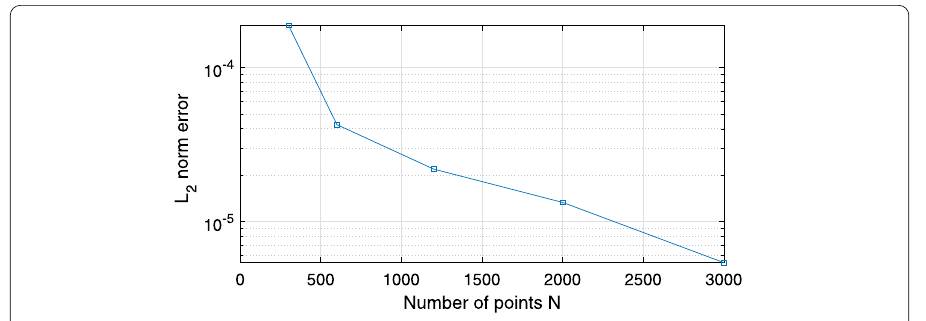
Figure 5 L 2 error measured for u obtained by the numerical process against the grid of nodes N with w = 0.5 and